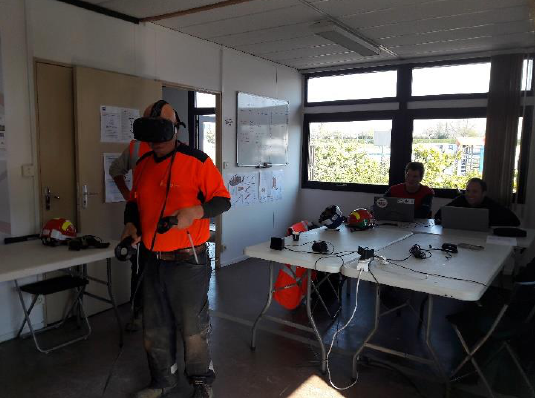
Fig. 6. The first test on construction site at stade Maurice Boyau project, DAX, France.